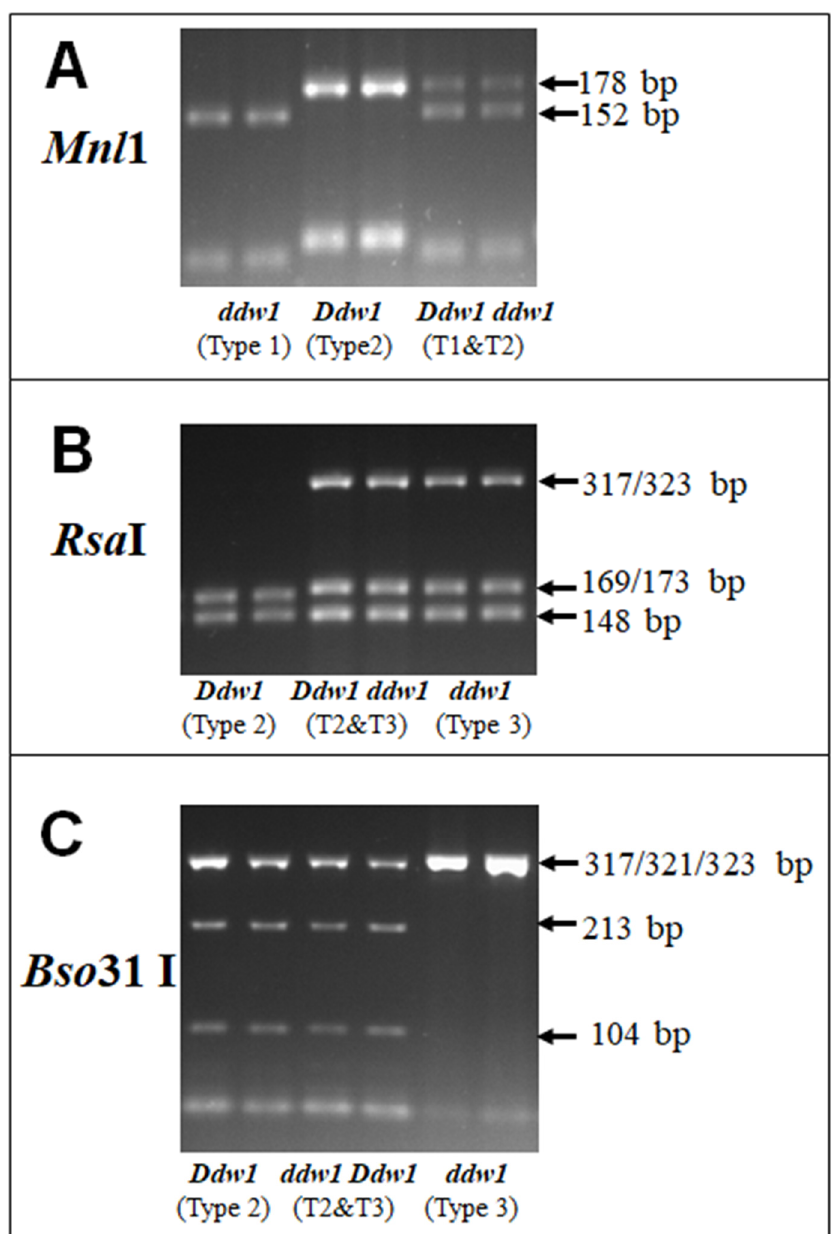
Figure 3. Examination of Mnl 1, Rsa I, and Bso 31I restriction endonucleases for CAPS marker: 2% agarose electrophoresis of REMS1218 PCR products of di ff erent genotypes after digestion by these restrictases. The types of REMS1218 PCR products were determined by capillary electrophoresis. The size of the restriction fragments are given based on our sequences of REMS1218 PCR products. ( A ) Digestion of homozygous Types 1 (T1) and 2 (T2), and heterozygous T1&T2 REMS1218 products by Mnl 1 ( Mnl 1 does not cleave Type 3 and Type 2, so these results are not shown); ( B ) Digestion of homozygous Types 2 and 3 and heterozygous T2&T3 by Rsa I ( Rsa I does not cleave Type 1 and Type 2, and these results are not shown); ( C ) Digestion of homozygous Types 2 and 3 and heterozygous T2&T3 by Bso 31I (Type 1 is cleaved by Bso 31I and gives 213 bp and 104 bp products only; the data is not shown). Based on the nucleotide sequences and the results of the gel electrophoresis of digested